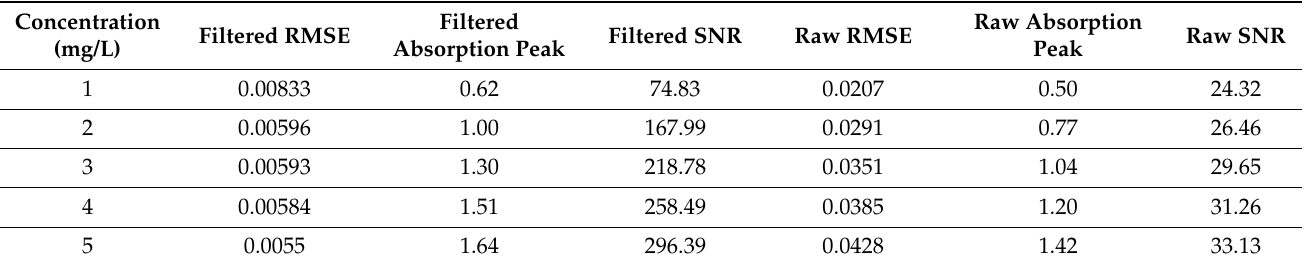
Table 3. Calculation results of spectrum